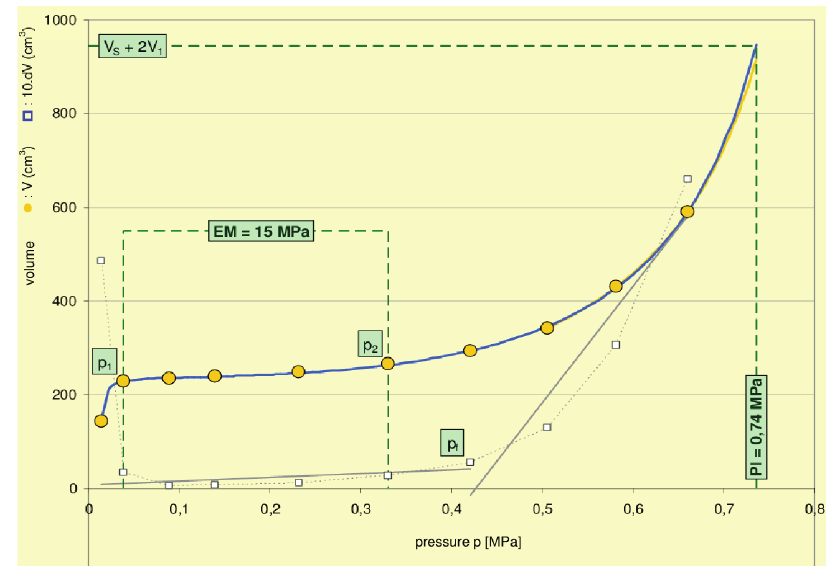
Fig. 8. Pressuremeter curve, depth 3